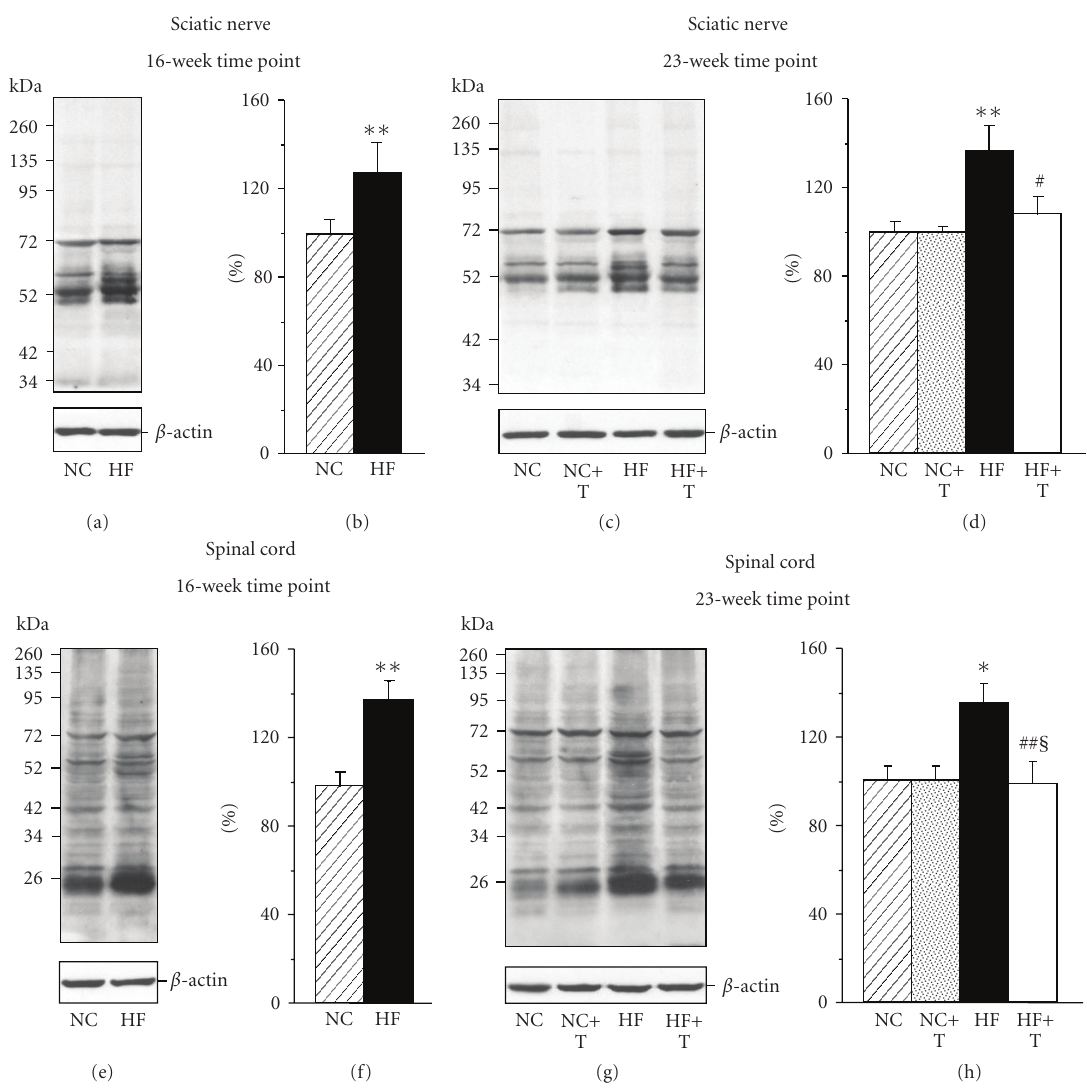
Figure 3: Representative Western blot analyses ((a), (c), (e), (g)) and content (densitometry, ((b), (d), (f), (h))) of mouse sciatic nerve ((a)– (d)) and spinal cord ((e)–(h)) nitrated protein expressions after 16-week ((a), (b) and (e), (f)) and 23-week ((c), (d) and (g), (h)) feedings with normal chow or high-fat diet with or without PMI-5011. NC: normal chow, HF: high fat diet, T: treatment. Mean ± SEM, n = 7-8 per group. ∗ , ∗∗ P < . 05 and < . 01 versus mice fed NC; § P < . 05 versus the baseline value (16-wk time point); #,## P < . 05 and < . 01 versus mice fed